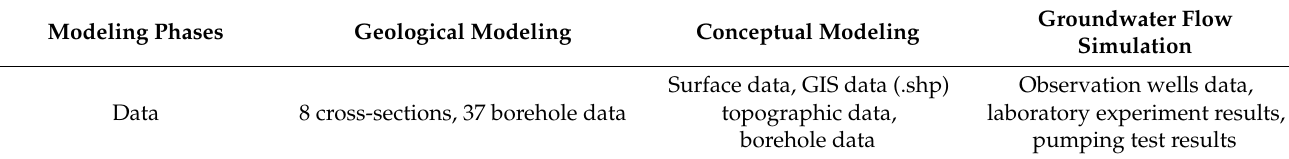
Table 1. Utilized data for this work.